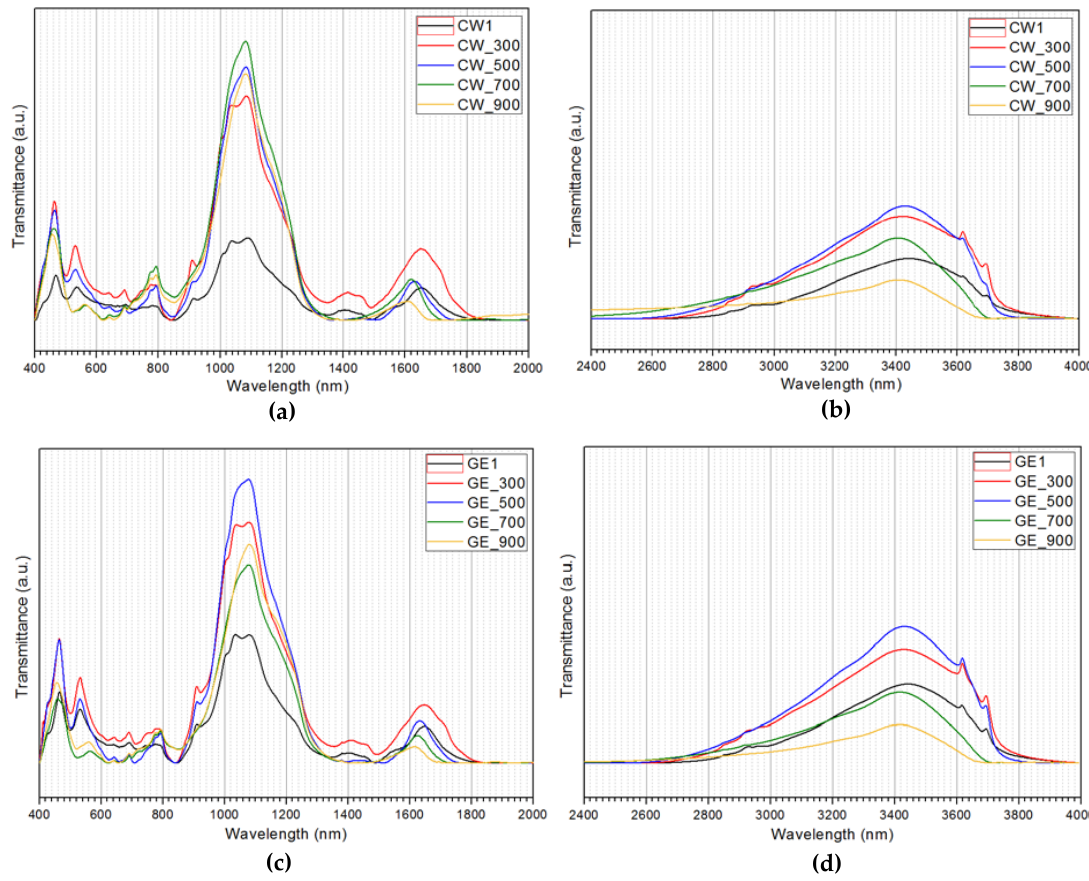
Figure 2. FT-IR results for the two types of sludge in different wavelegth ranges: (a) CW 400–2000 cm − 1 , (b) CW 2000–4000 cm − 1 , (c) GU 400–2000 cm − 1 , and (d) GU 2000–4000 cm − 1 .